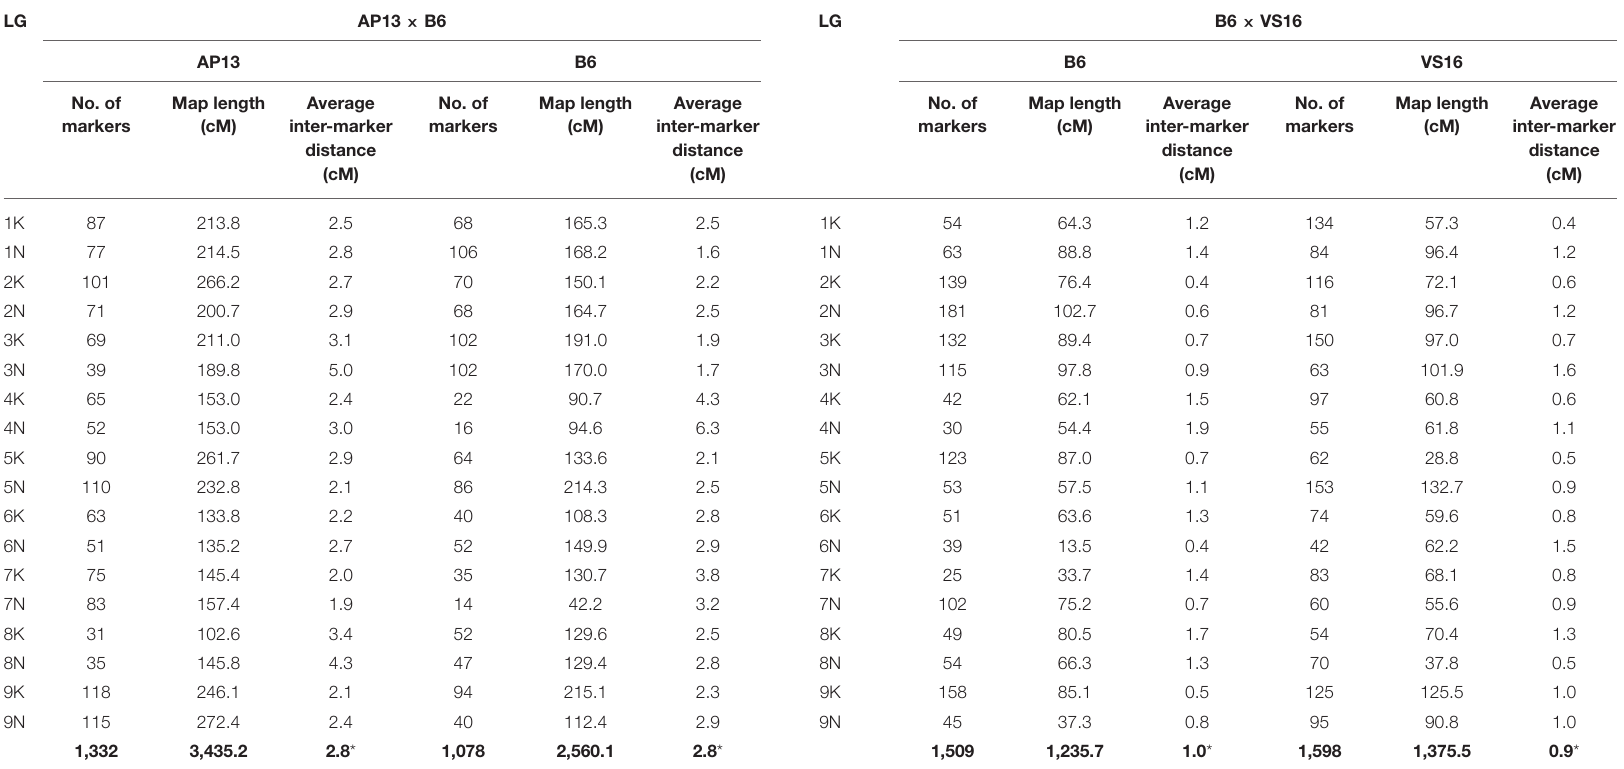
TABLE 1 | Marker numbers, map length (cM), and average inter-marker distances for each parental map in AP13 × B6 and B6 × VS16